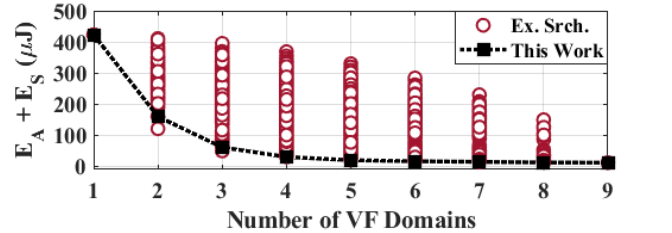
Figure 4. Exhaustive search iterations and the minimum curve captured by the proposed algorithm.